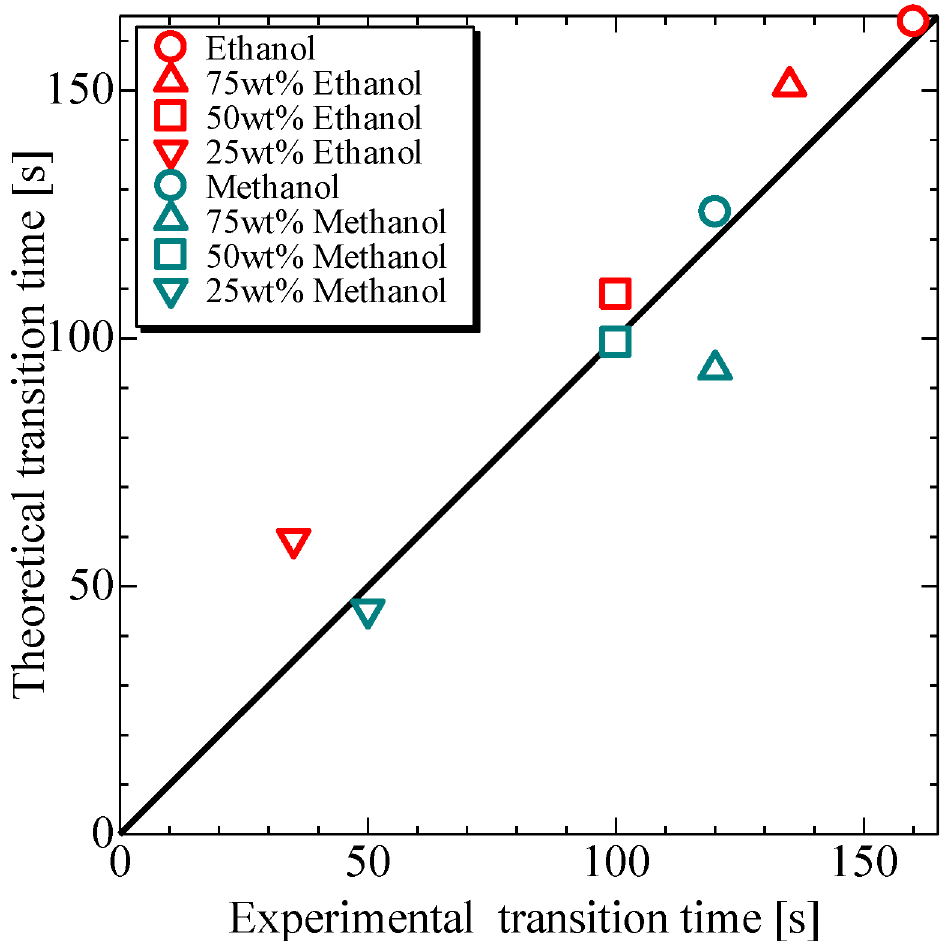
Fig 9. Experimental and theoretical transition time of ethanol and methanol solution droplets. (Ethanol) 100 wt%: d 0 = 1.4 mm, P rms = 1.5 kPa, b/a = 1.7, 75 wt%: d 0 = 1.4 mm, P rms = 1.7 kPa, b/a = 1.8, 50 wt%: d 0 = 1.5 mm, P rms = 1.5 kPa, b/a = 1.5, 25 wt%: d 0 = 1.4 mm, P rms = 1.8 kPa, b/a = 1.3. (Methanol) 100 wt%: d 0 = 1.4 mm, P rms = 1.5 kPa, b/a = = 1.7 mm, P = 1.5 kPa, b/a = 1.5, 50 wt%: d = 1.5 mm, P = 1.5 kPa, b/a = 1.4, 25 wt%: d = 1.5 1.6, 75 wt%: d 0 rms 0 rms 0 mm, P rms = 1.9 kPa, b/a =